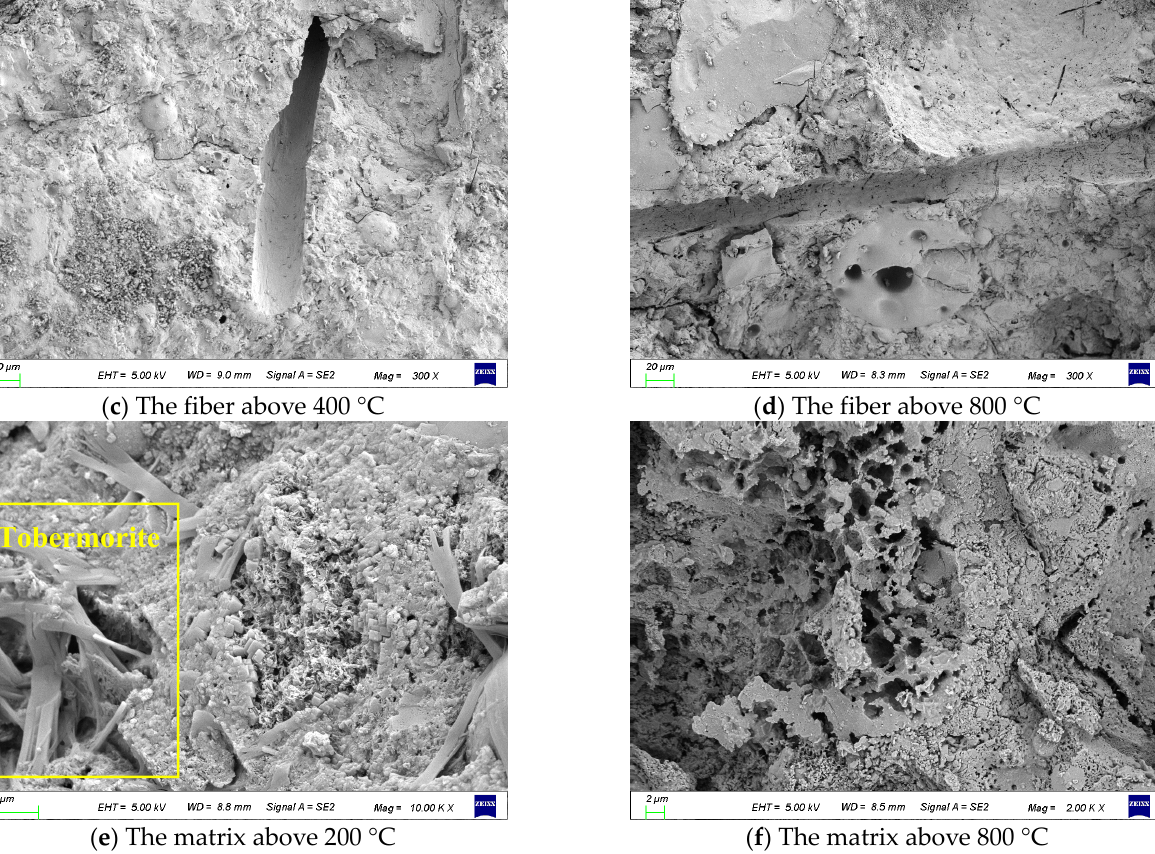
Figure 13. SEM images of UHPC after exposure to high temperatures.